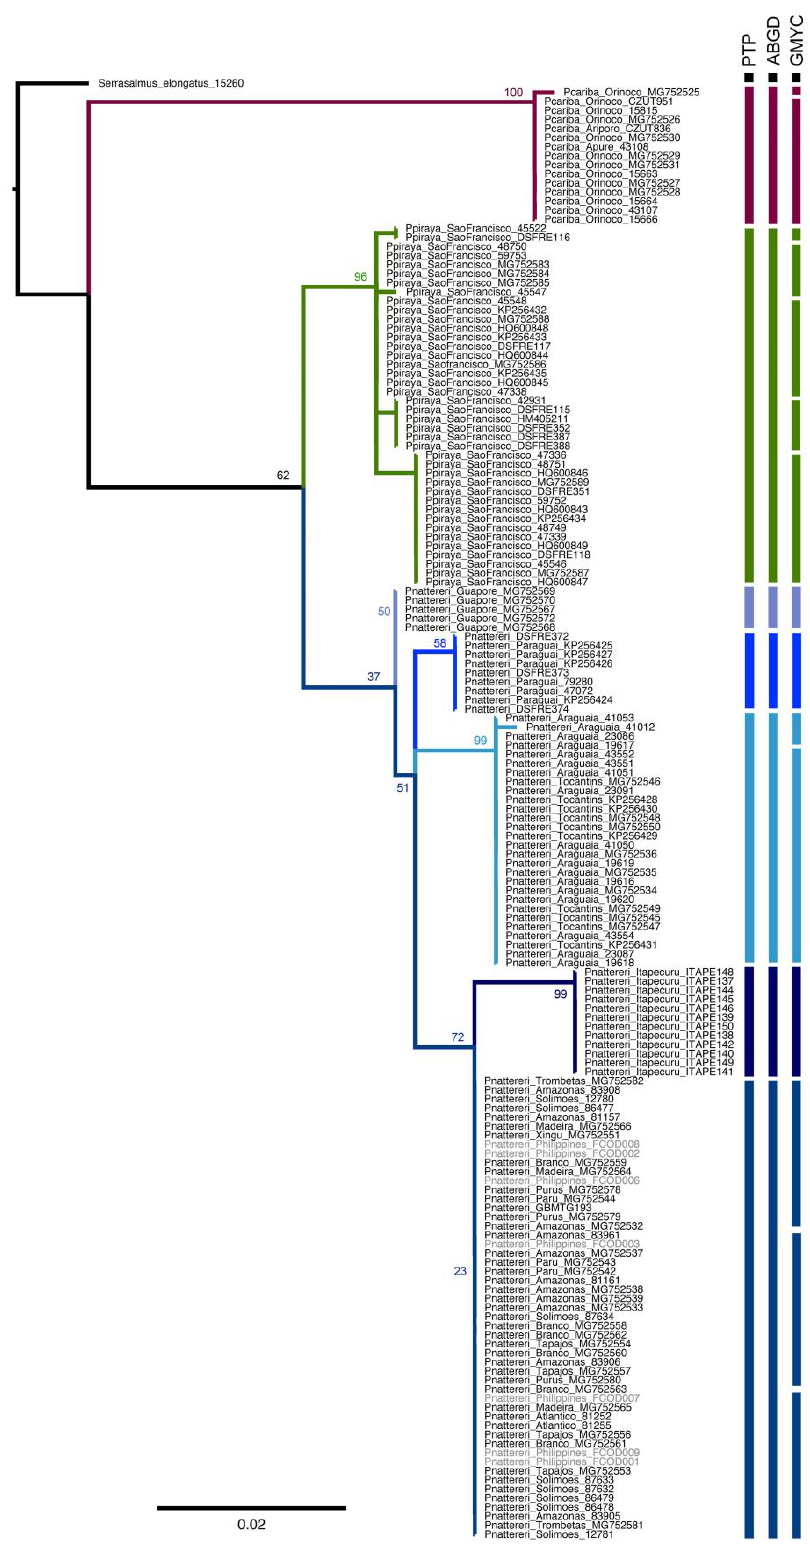
Figure 3. Best maximum likelihood tree based on the cytochrome c oxidase subunit I gene for Pygocentrus species evidencing the presence of multiple genetic lineages within P. nattereri . Colored bars after tip names represents results of the three species delimitation analyses. GMYC results for the Amazonas lineage of P. nattereri are not delimited by taxa. Numbers near nodes indicate bootstrap support.